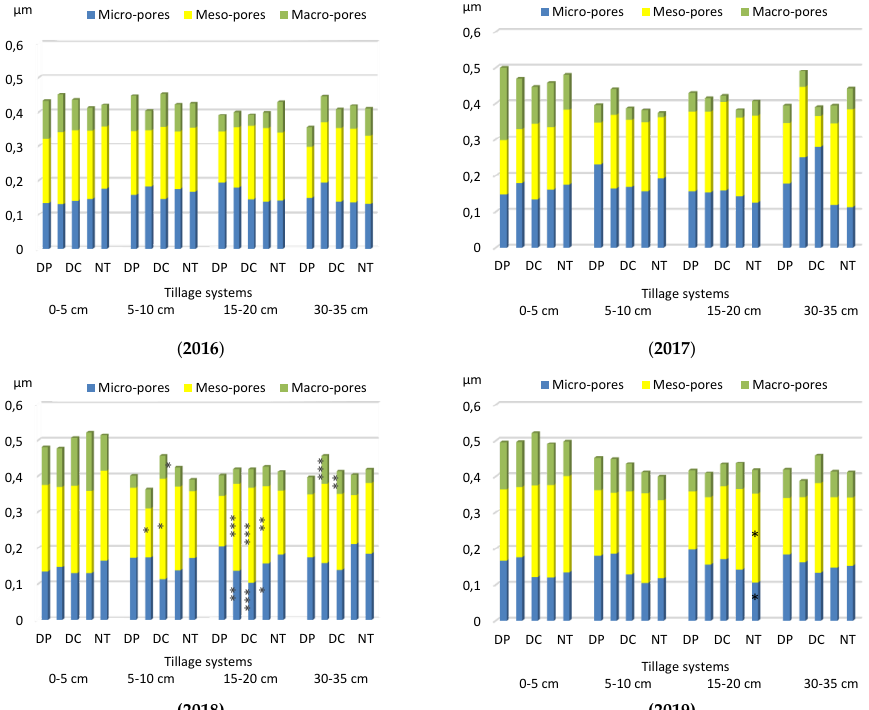
Figure 2. Impact of tillage intensity on soil pore size distribution at different layers, 2016–2019. Notes: DP—deep ploughing (control treatment); SP—shallow ploughing; DC—deep cultivation; SC—shallow cultivation; NT—no tillage (direct drilling). *—significant difference at 0.01 < p ≤ 0.05; **—at 0.001 < p ≤ 0.01; ***—at p ≤ 0.001. The significance of data was determined by Fisher’s least significant difference (LSD) test.